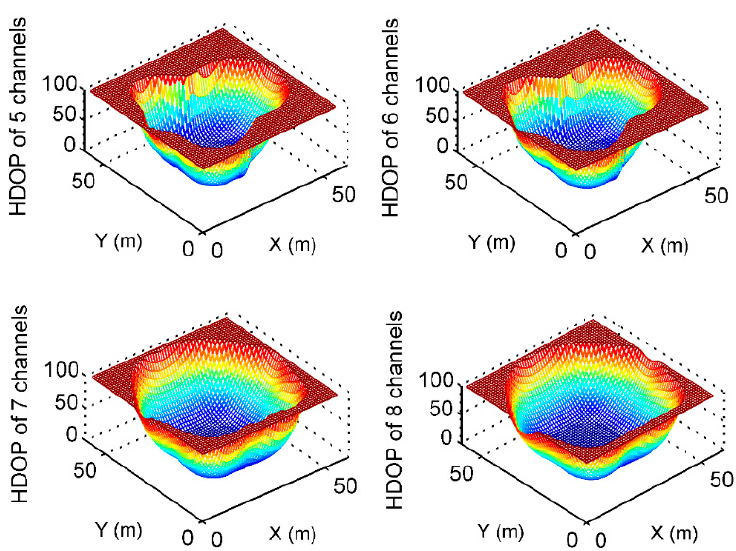
Figure 12. HDOP using Doppler positioning algorithm from 5 to 8 channels.